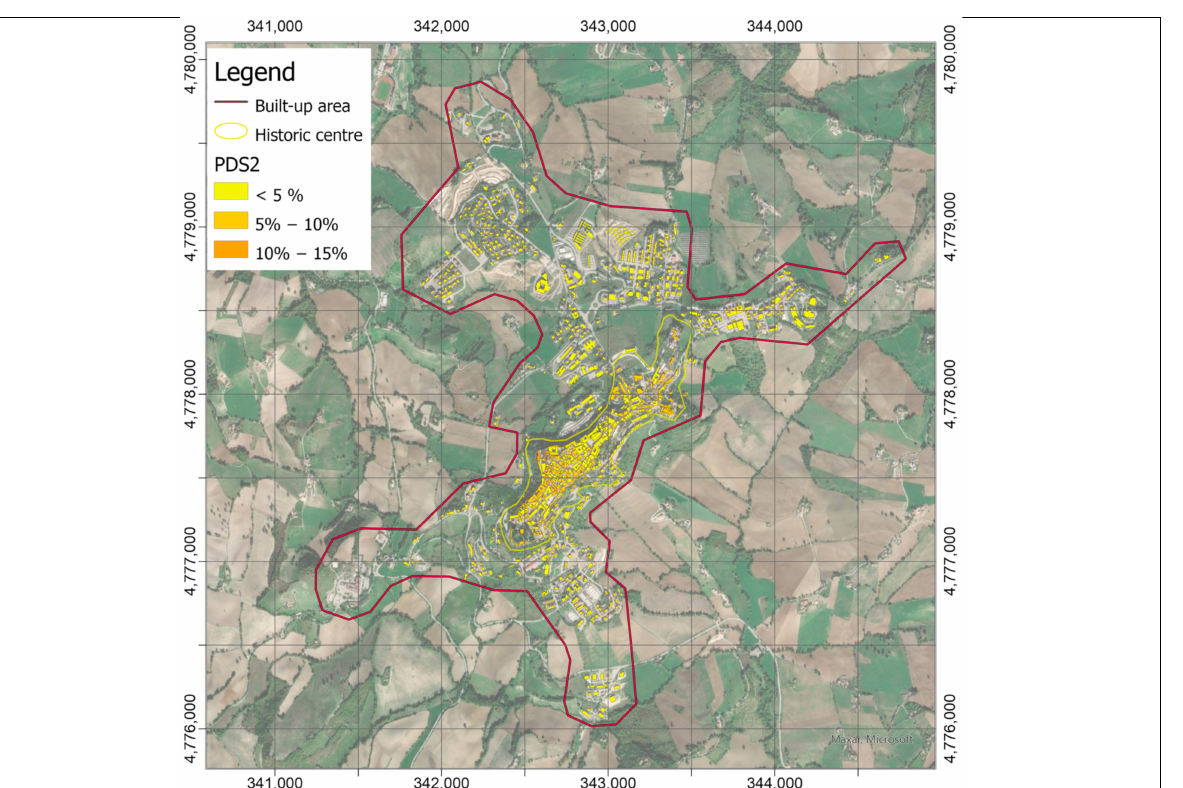
Figure 13. Probabilities map to reach or exceed the DS2 damage levels of the EMS-98 scale. The map is obtained by means of the relationship (1) with parameters θ DS 2 and β in Table 1 according to building classification in Figure 11 and accelerations in Figure